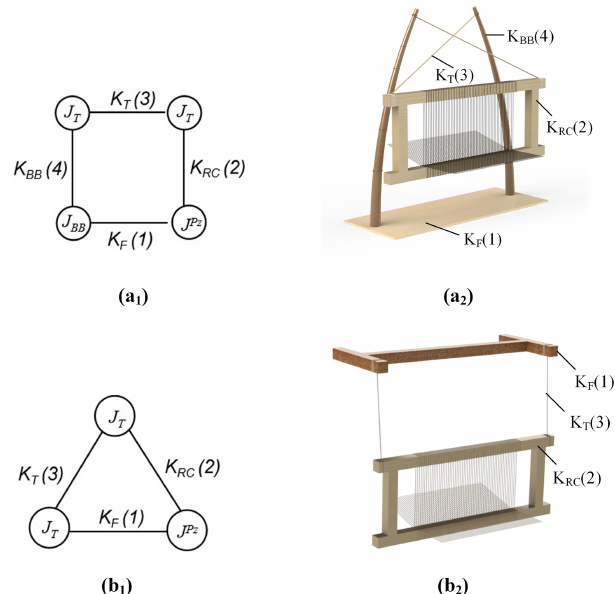
Figure 10. Chains and simulation drawing of the weft-pressing mechanism.